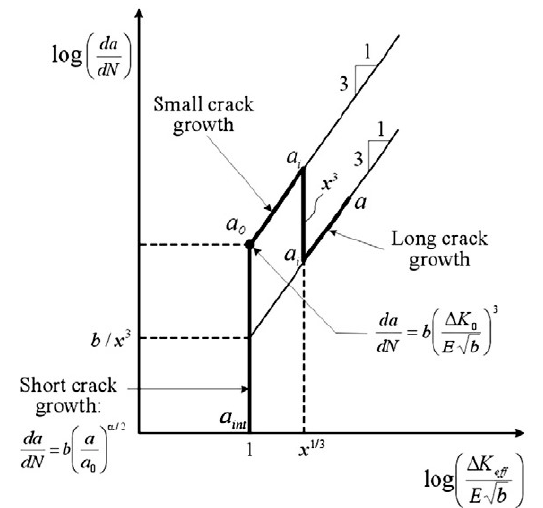
Figure 5. Crack advance diagram in HCF [17,18]: b is the Burgers vector, ∆ K 0 and ∆ K ef f are the stress intensity factors corresponding to the crack lengths a 0 and a i .